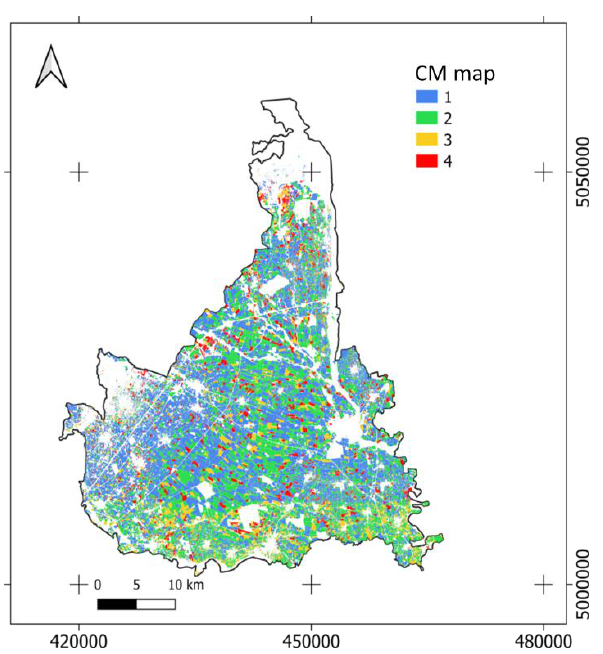
Figure 8. Controls map (CM). Code meaning is reported in Table 9. (Reference system is WGS 84/UTM zone 32N, EPSG: 32632).